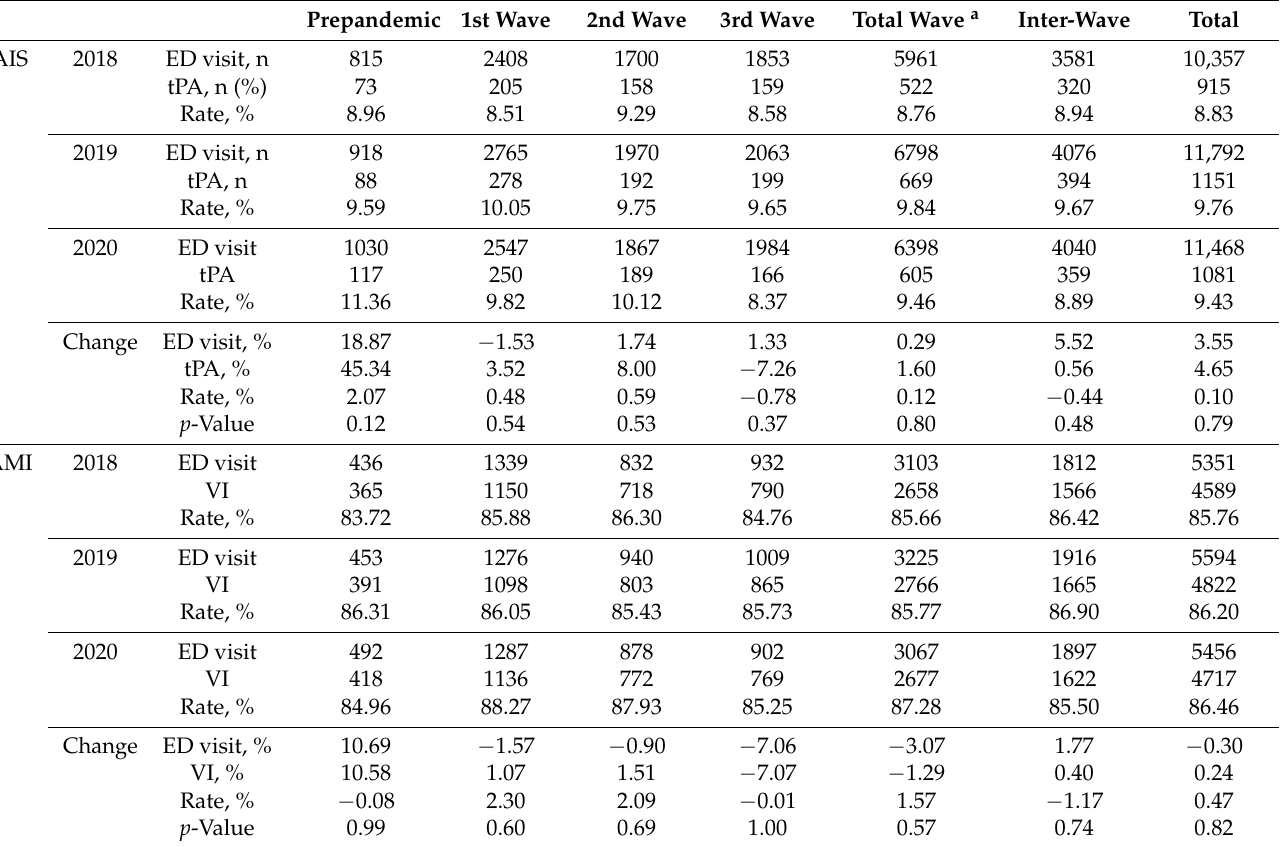
Table 3. Changes in the urgent management for patients with acute ischemic stroke and myocardial infarction in the ED from 2018 to